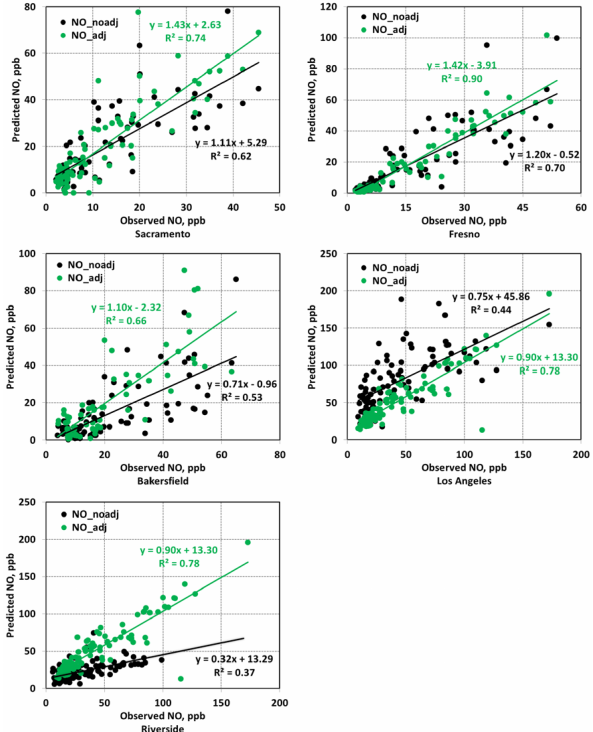
Figure 7. Monthly average NO concentrations adjusted with the predicted/observed CO ratios. NO_noadj represents the NO con- centrations in the UCD/CIT model predictions, and NO_adj repre- sents the NO concentrations adjusted with observations as NO_adj = NO_noadj × CO_predicted / CO_measured.